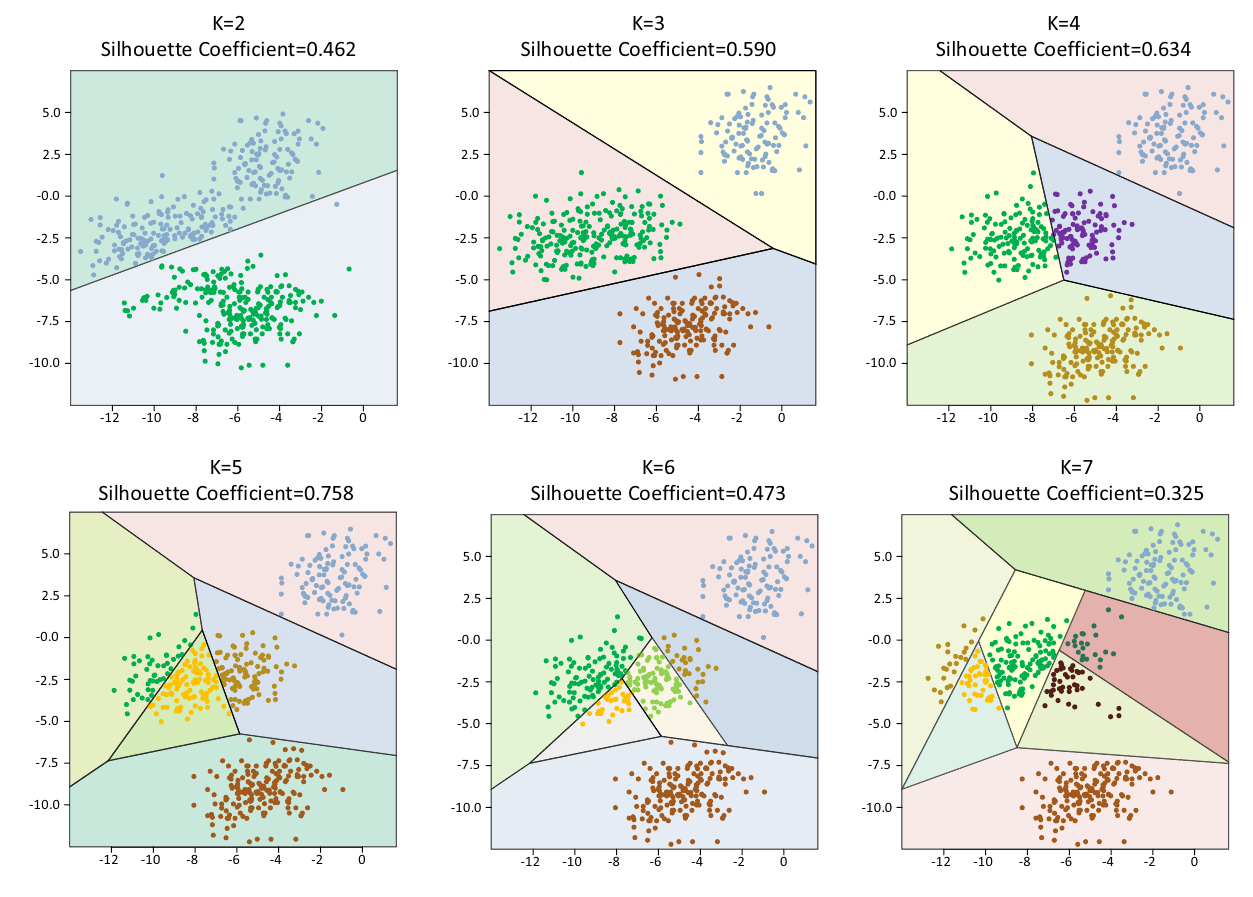
Figure 8. Silhouette coefficients analysis of different clustering categories.